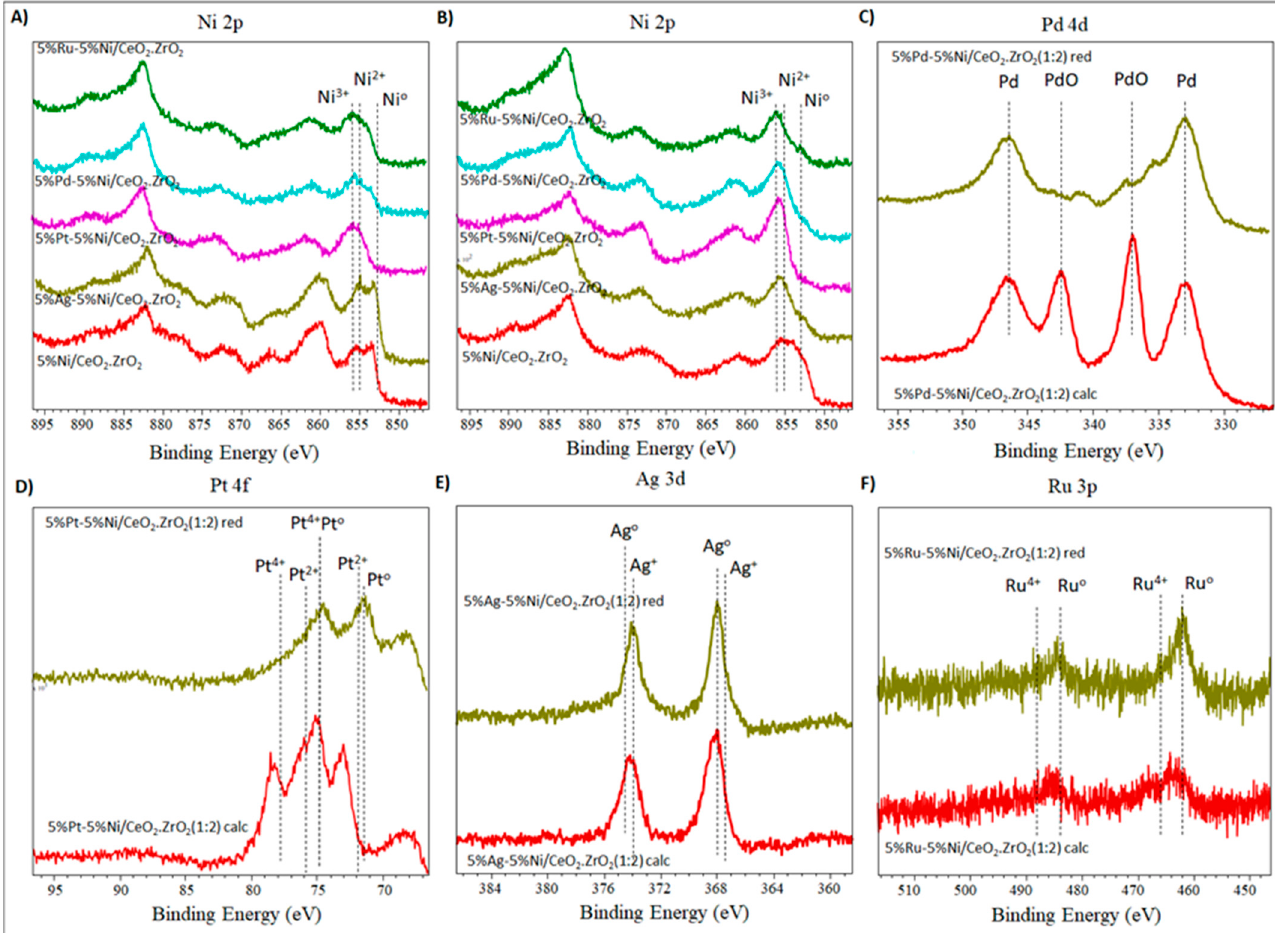
Figure 10. ( A ) Ni 2p XPS of mono ‐ and bimetallic Ni catalysts calcined in an air atmosphere at 400 °C ( B ) Ni 2p XPS of mono ‐ and bimetallic Ni catalysts reduced in a mixture of 5%H 2 ‐ 95%Ar at 500 °C for 1 h ( C ) Pd 4d XPS of calcined and reduced bimetallic 5%Pd ‐ 5%Ni/CeO 2 ∙ ZrO 2 (1:2) catalysts ( D ) Pt 4f XPS spectra of calcined and reduced bimetallic 5%Pt ‐ 5%Ni/CeO 2 ∙ ZrO 2 (1:2) catalysts ( E ) Ag 3d XPS of calcined and reduced bimetallic 5%Ag ‐ 5%Ni/CeO 2 ∙ ZrO 2 (1:2)catalysts ( F ) Ru 4d XPS of calcined and reduced bimetallic 5%Ru ‐ 5%Ni/CeO 2 ∙ ZrO 2 (1:2) catalysts. The Pd 3d spectra of bimetallic 5%Pd ‐ 5%Ni/CeO 2 ∙ ZrO 2 (1:2) catalysts are shown in Figure 10C. Four main peaks can be easily distinguished in the XPS spectra of the calcined catalysts located at 333, 337, 342.5, and 340.5 eV and 347 eV. The observed peaks are as ‐ signed to metallic palladium and PdO [36,37]. The results clearly confirm that the signals assigned to PdO disappear after the reduction process for bimetallic catalysts in a mixture of 5%H 2 ‐ 95%Ar at 500 °C for 1h. It is also worth to mention that the appearance of low